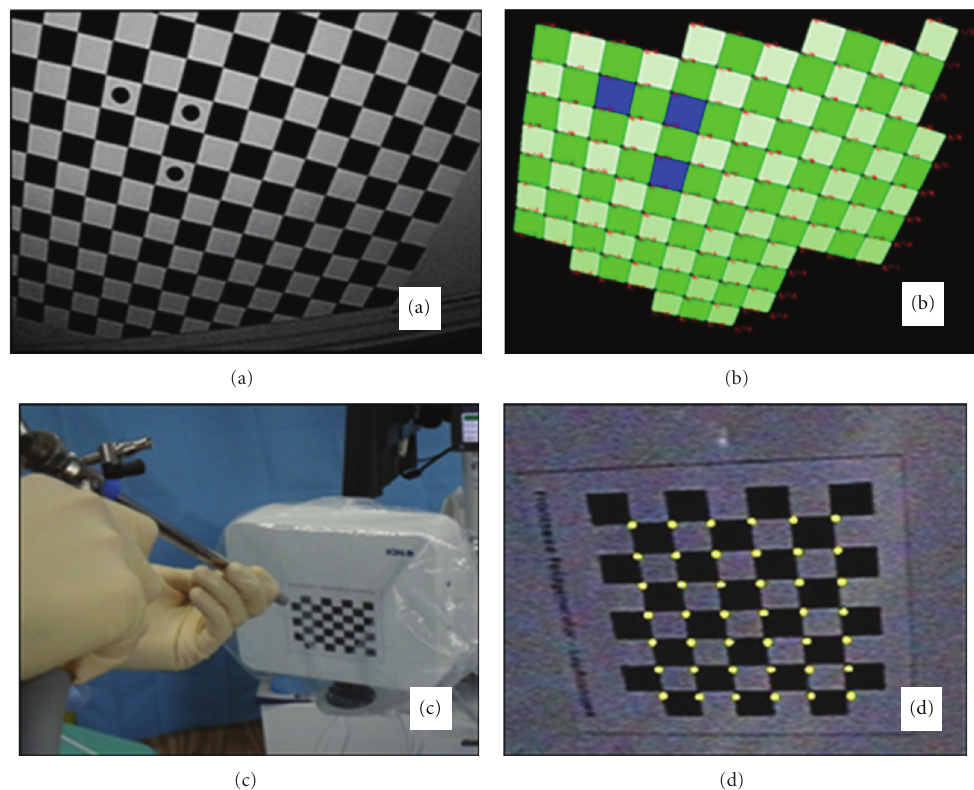
Figure 4: Calibration of the camera. (a) Monitor picture, (b) virtually generated squares, (c) exposure of the squares to the camera, (d) calibrated camera view by definition of square crossings.